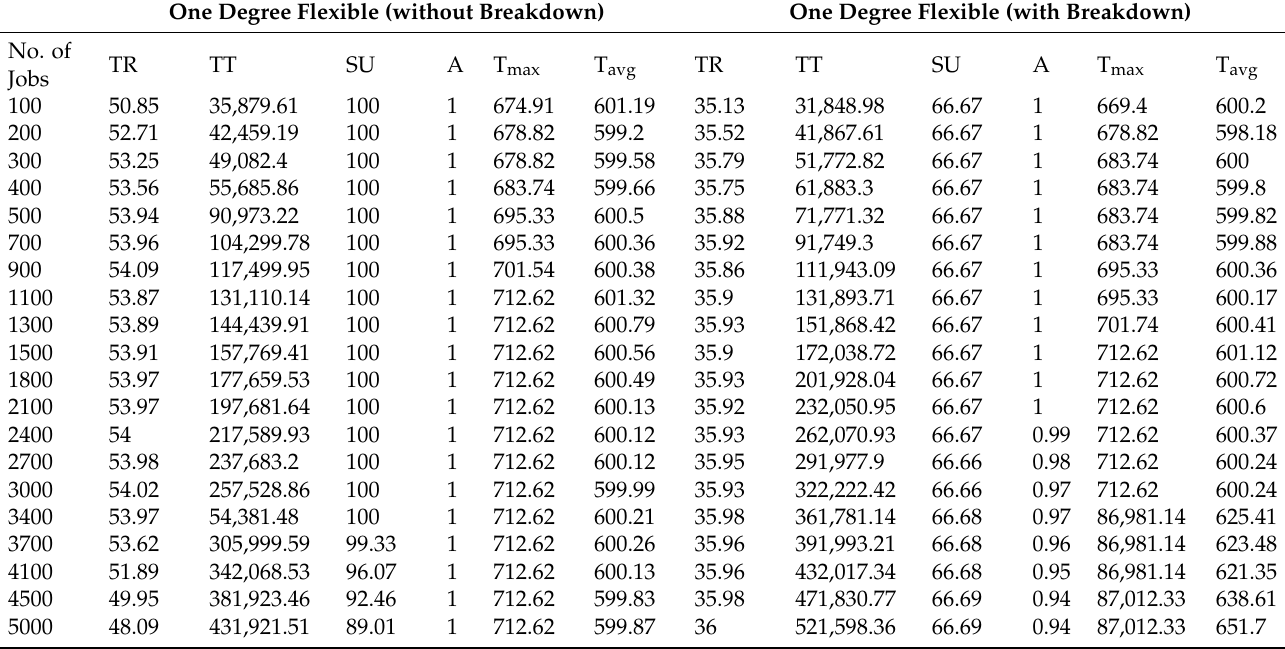
Table 3. Comparative Simulation Matrix of one-degree configuration without and with breakdown of machines.